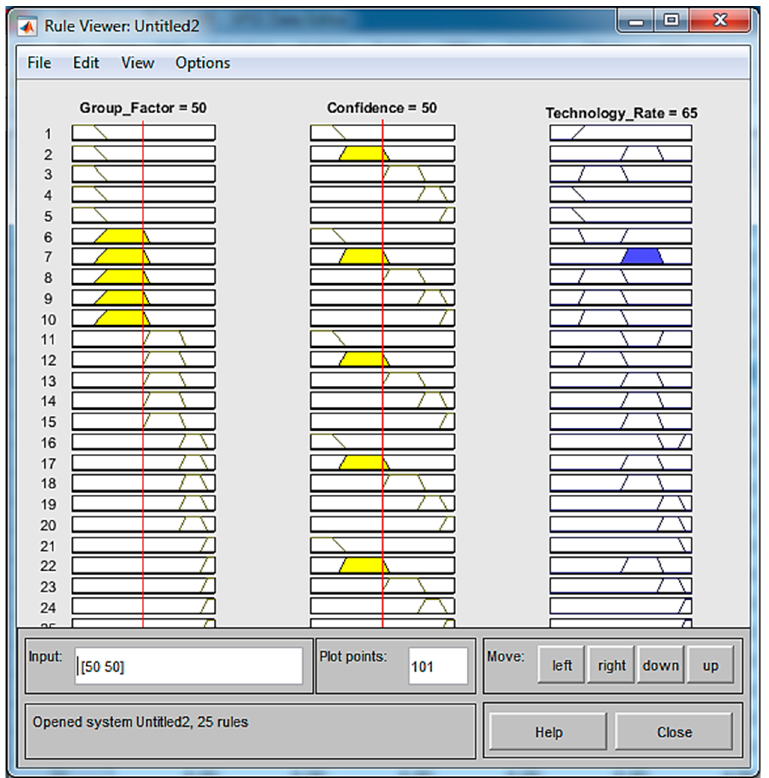
Figure 14. The estimation of the technology rate (current technology = 50; confidence = 50). However, the same FIS proposes 37.5 for technology rate, while current technology is 35 and confidence is 90 (Figure 15).